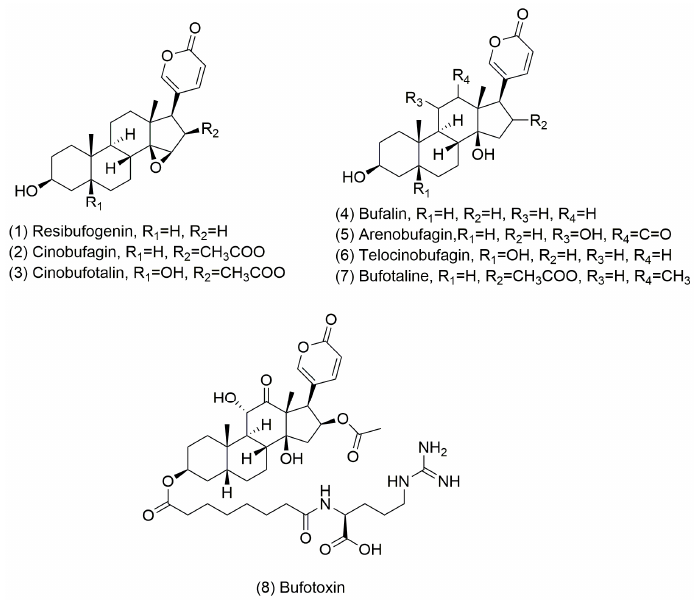
Figure 1. The structural formula of the eight bufadienolide-like chemicals.